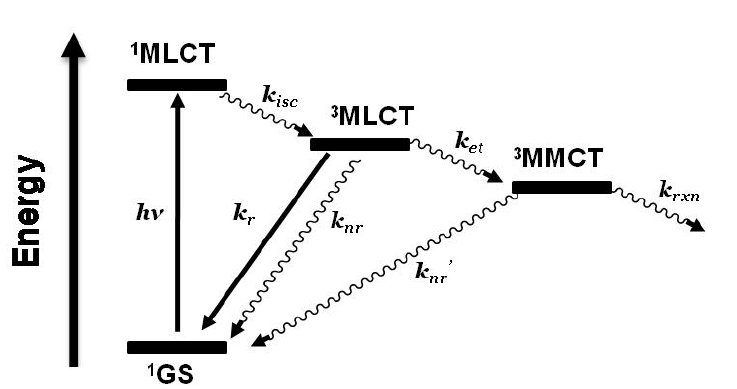
Figure 6. State diagram for Ru(II),Rh(III) supramolecular assemblies. GS = ground